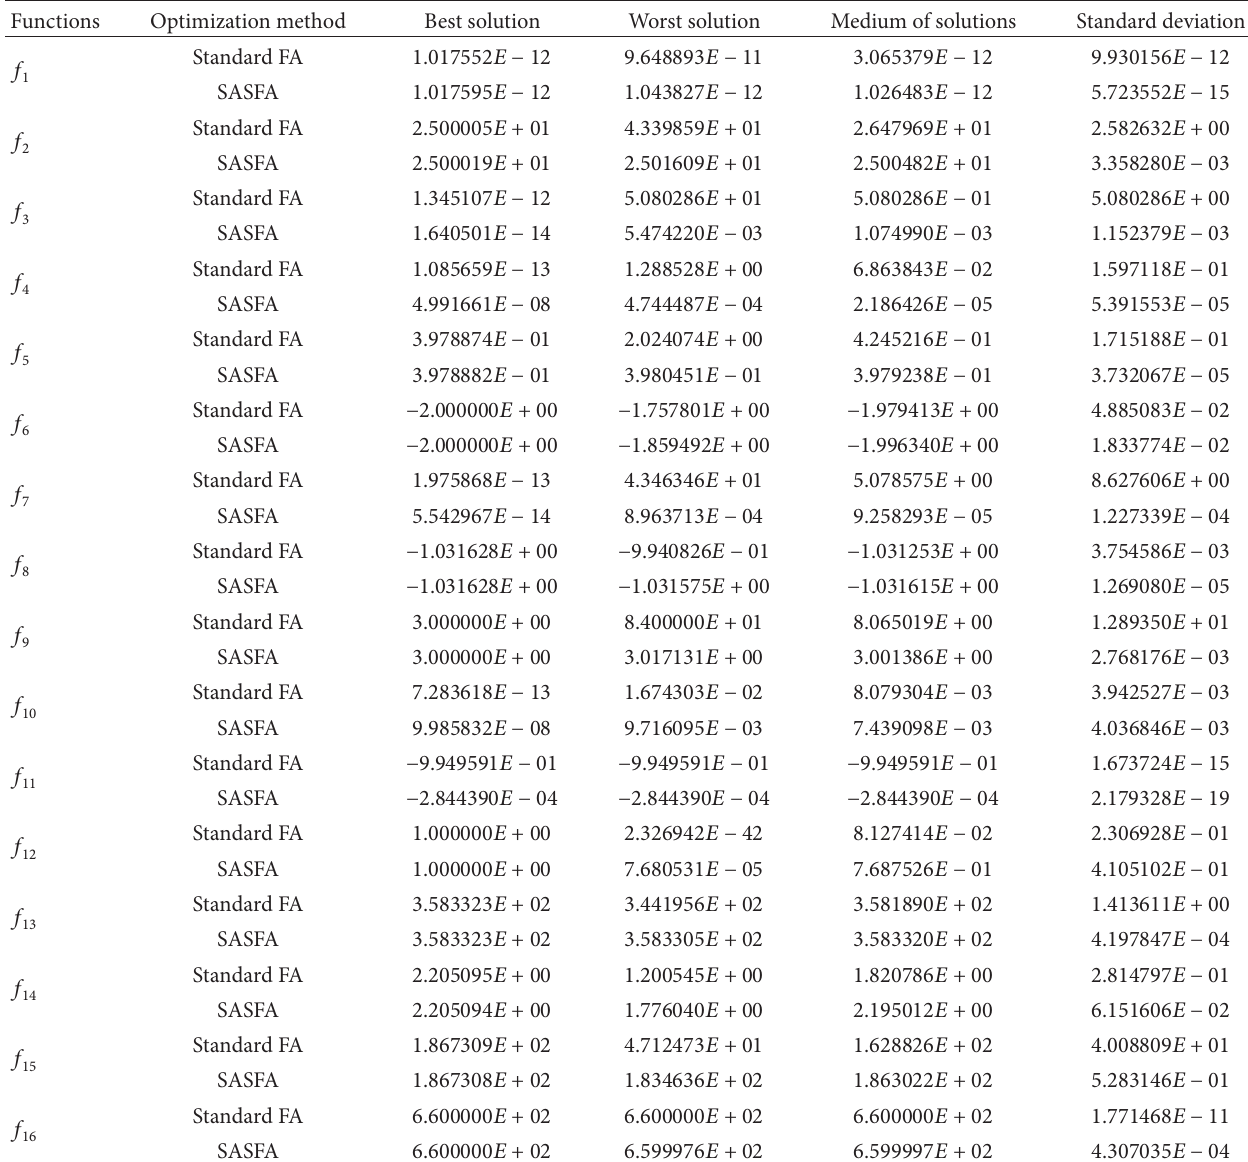
Table 2: Comparison of standard FA and